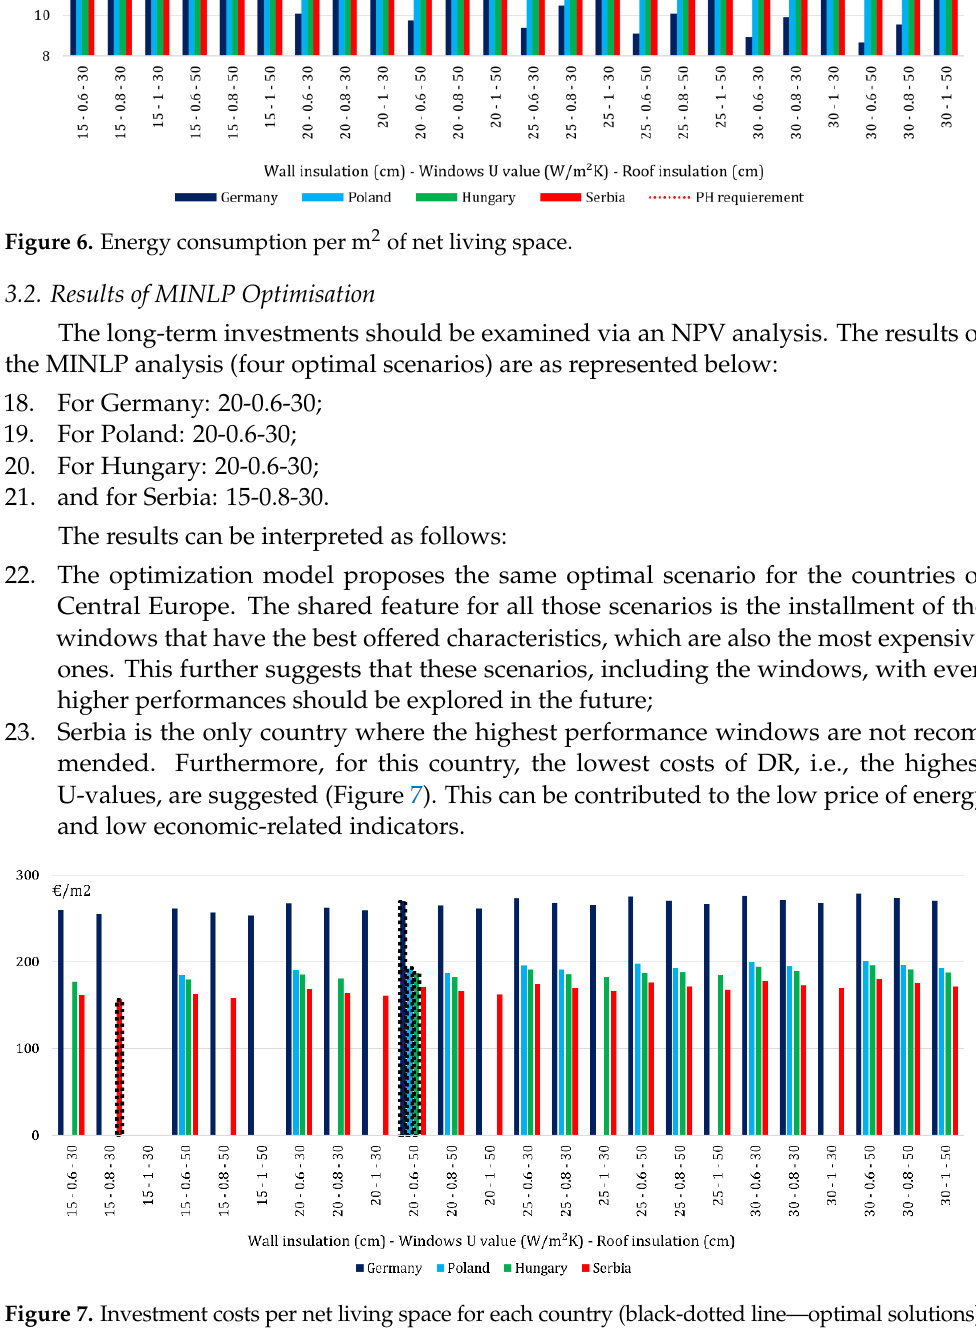
Figure 7. Investment costs per net living space for each country (black-dotted line—optimal solu- tions).